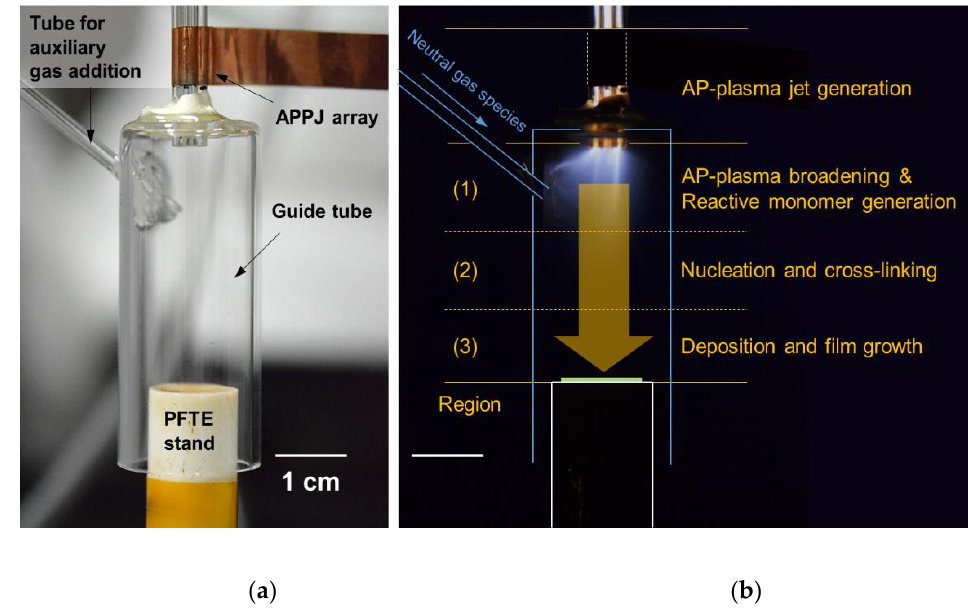
Figure 2. AP plasma reactor: ( a ) labeled photographic image; ( b ) graphical description of the se- quence of AP plasma polymerization inside the guide tube. sequence of AP plasma polymerization inside the guide